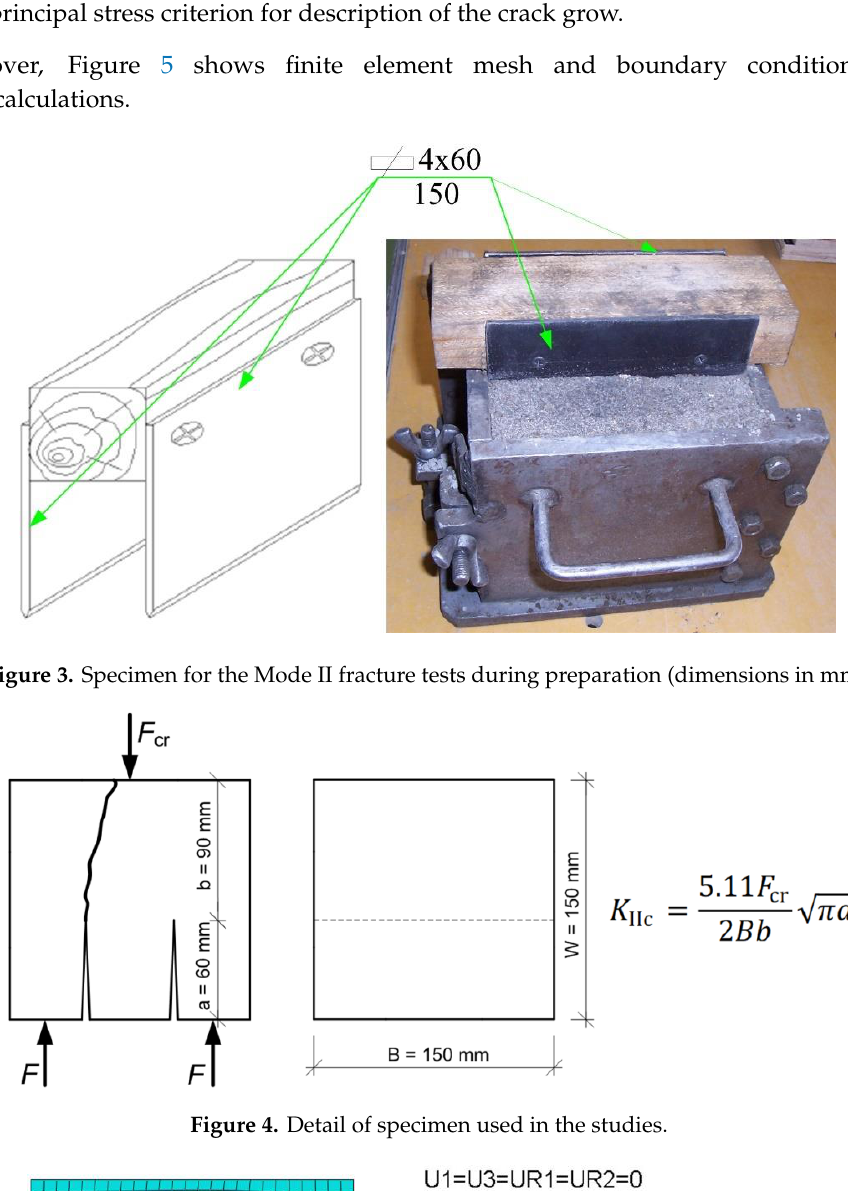
Figure 2. Preparation process of the specimen for fracture toughness tests.